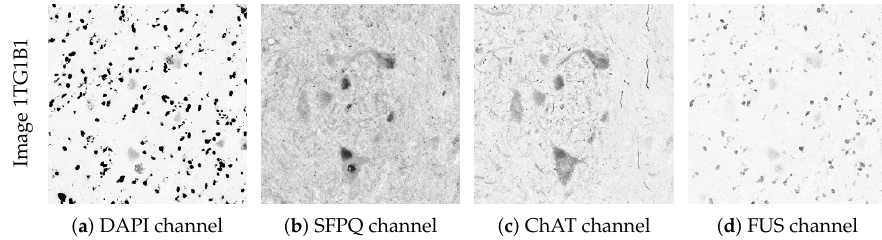
Figure 3. Original images from the ALS dataset, all from the same tissue observation, where: ( a ) is the image from Channel 1 (DAPI); ( b ) is the Channel 2 (SFPQ) image; ( c ) contains the Channel 3 (ChAT) image; and ( d ) shows the Channel 4 (FUS)